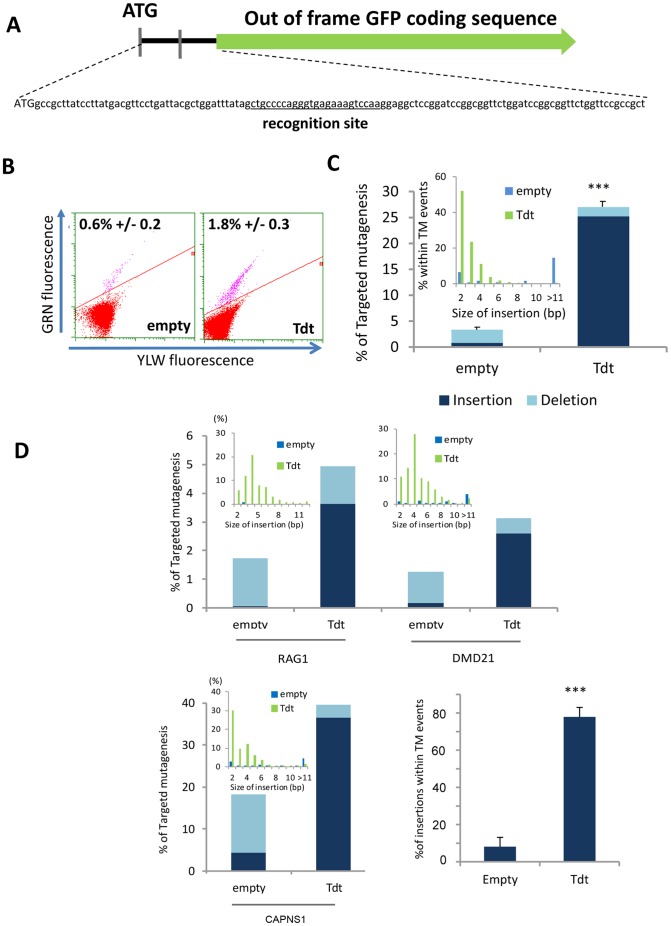
Effect of Tdt on meganuclease-induced mutagenesis.(A) Schematic representation of the transgene measuring NHEJ activity. A GFP gene lacking the ATG start codon was cloned out of frame and downstream of an exogenous sequence containing a meganuclease recognition site. (B) Quantification by flow cytometry of GFP positive cells 3 days post transfection with meganuclease alone (empty) or with meganuclease and Tdt (Tdt); experiments performed in triplicate. (C) Determination of TM of 2 independent experiments by sequence analysis of locus specific amplicons (454 Roche). On average, 10,000 amplicons were sequenced per experiment. Dark blue, insertion events; light blue, deletion events. The inset graph represents, as a function of insertion size, the percentage of meganuclease-induced TM with (green) or without (blue) Tdt. (D) Targeted mutagenesis at endogenous loci quantified by amplicon sequencing analysis. Meganucleases RAG1m, DMD21m (left panel) or CAPNS1m (right panel) were used either alone (empty) or with Tdt. Percentages of induced-TM are depicted as well the size of DNA insertions (inset graph). The mean percentage of insertion measured on the 3 endogenous loci is depicted.